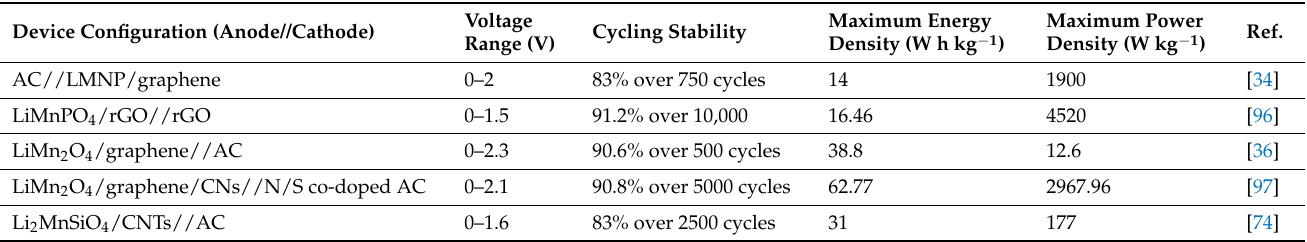
Figure 9. Lithium-ion capacitor performance of Li 2 MNSiO 4 /CNTs, ( a ) CV plots of nanocomposite @15 mV s −1 , ( b ) CV curve cell at different scan rates, ( c ) GCD curves at various current density values, ( d ) Nyquist plot of the device, ( e ) specific capacitance as a function of current density, ( f ) Ragone plot showing power density as a function of energy density for an asymmetric cell, ( g ) CV curves of two supercapacitor devices @ 10 mV s −1 when connected in series and parallel, ( h ) two parallel-connected devices powering a DC motor fan with inset showing the non-rotating motor fan, ( i ) two series-connected cells lighting up a blue LED, and ( j ) 8 red LEDs. Reproduced with permission [75]. Copyright 2020, American Chemical Society. Table 4. Summary of the performance of carbon-based coated manganese-based